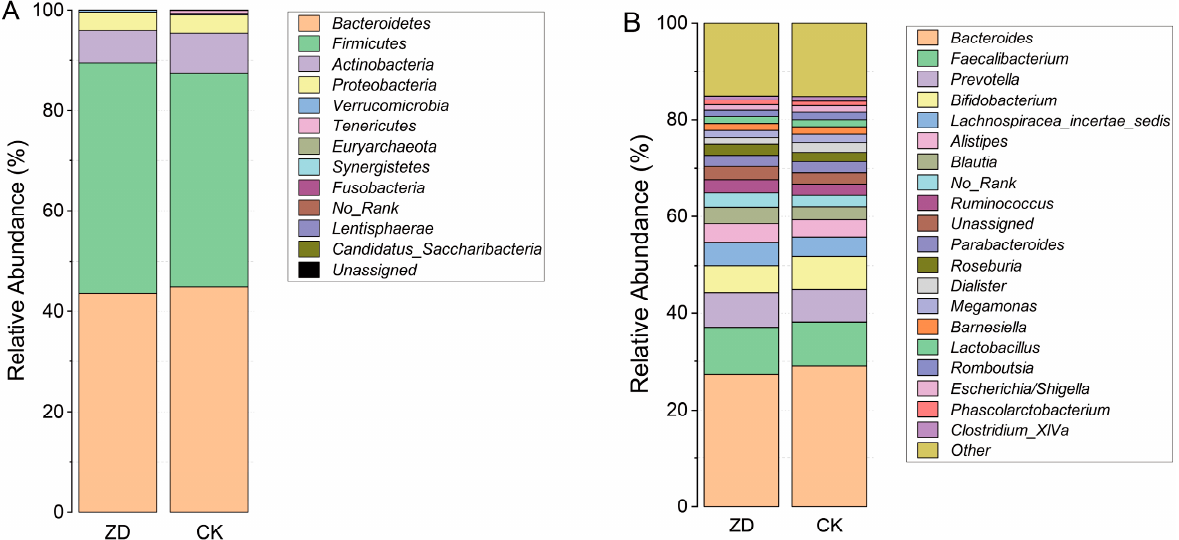
Figure 2. Bacterial composition between ZD and CK groups. ( A ) Microbial composition at phylum level; ( B ) Microbial composition at genus level.